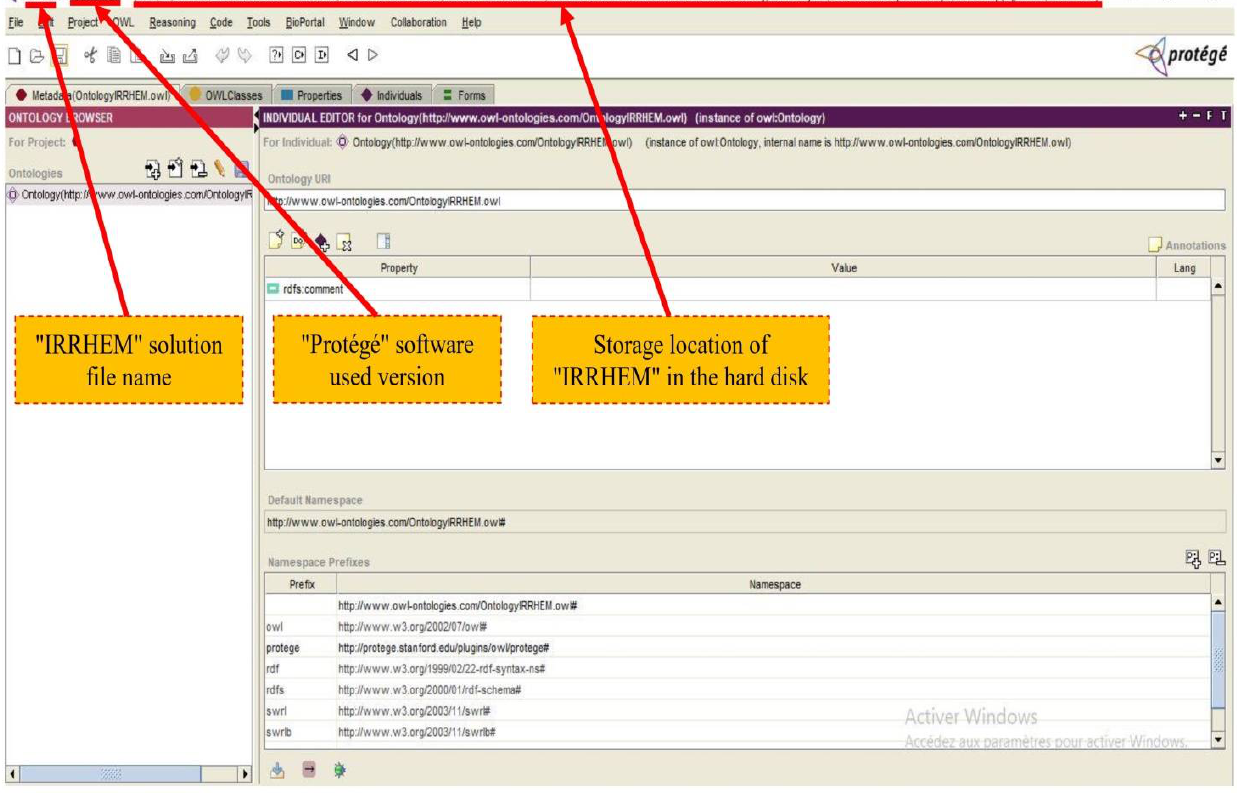
Figure 8. Editor “Protégé” graphical interfaces.